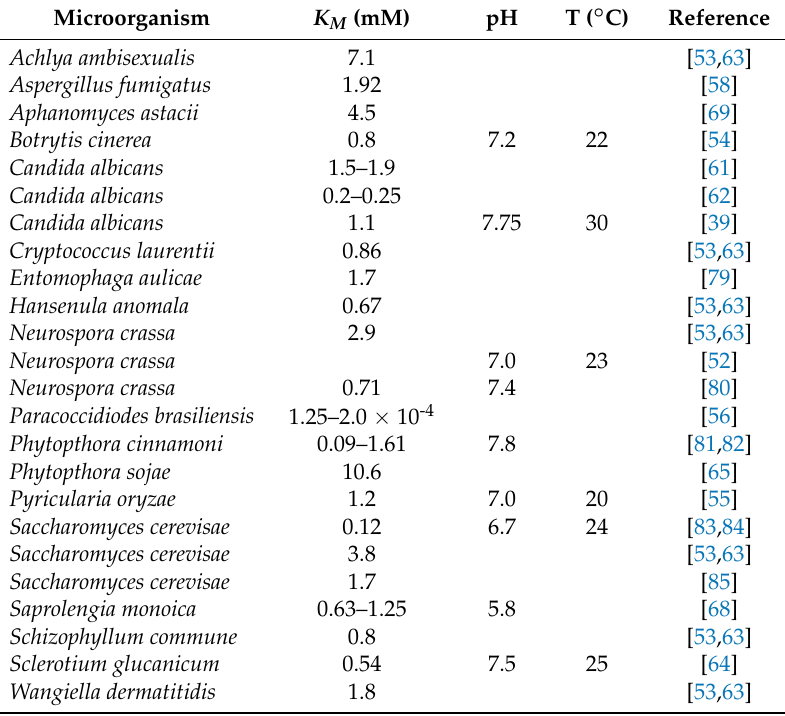
Table 1. Values of Michaelis constant ( K M ) for UDPG, optimum pH and temperature (T ◦ C) regarding GLS reported from different